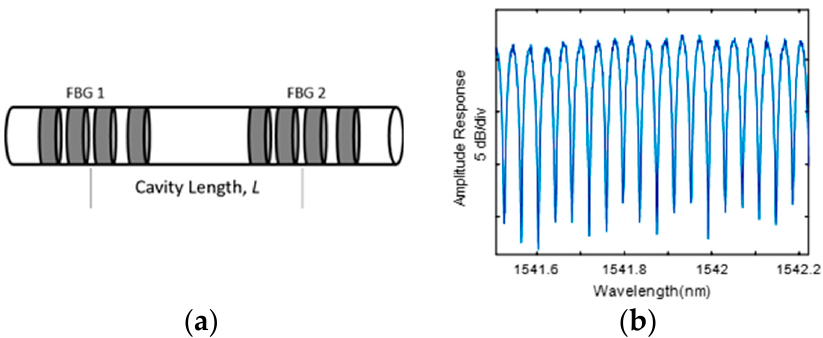
Figure 3. ( a ) Structure of an in-fiber FP cavity formed by two near-identical Fiber Bragg gratings (FBGs) and ( b ) zoom of the spectral fringe pattern of a typical device.